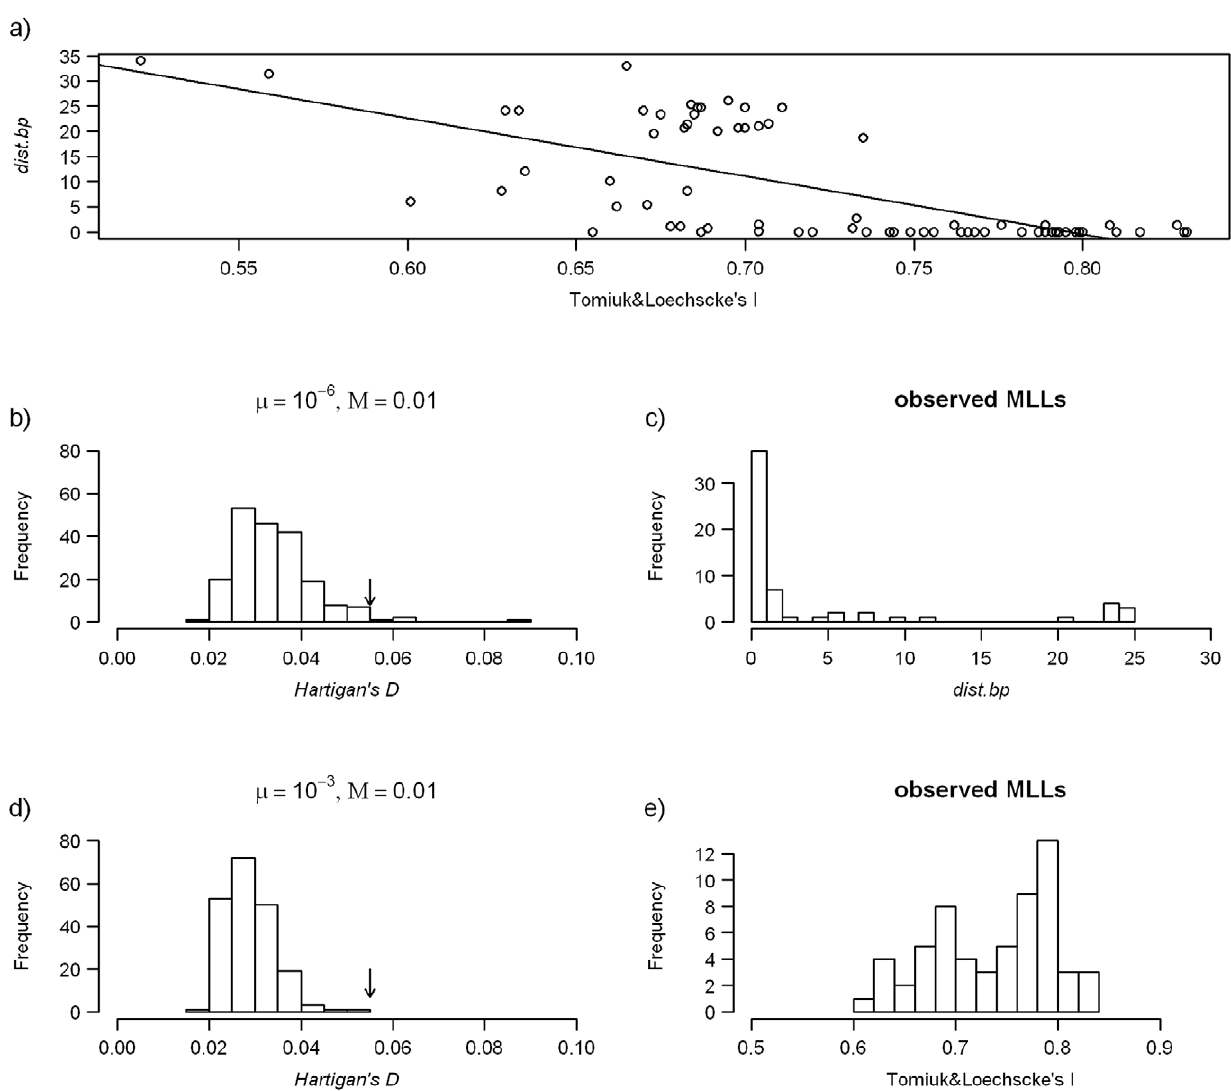
Figure 5. Observed and simulated distribution of clonal age estimators. (a) Correlation between the observed values of dist.bp and Tomiuk and Loeschcke’s I ; (b, d) Distributions of Hartigan’s D values calculated from simulated dist.bp histograms at every 200 th generation of the simulation. Each value was calculated from a 50:50 mixture of sympatric and allopatric clones. Arrows indicate the observed value; frequency distributions of the observed values of dist.bp, and I , respectively (c,